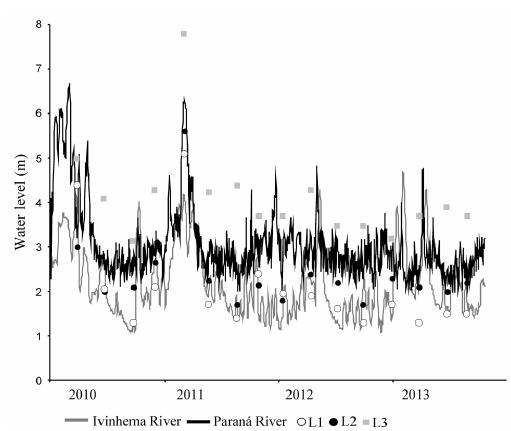
Figure 2. Paraná River (R1) and Ivinhema River (R2) daily water levels and maximum depth (Z